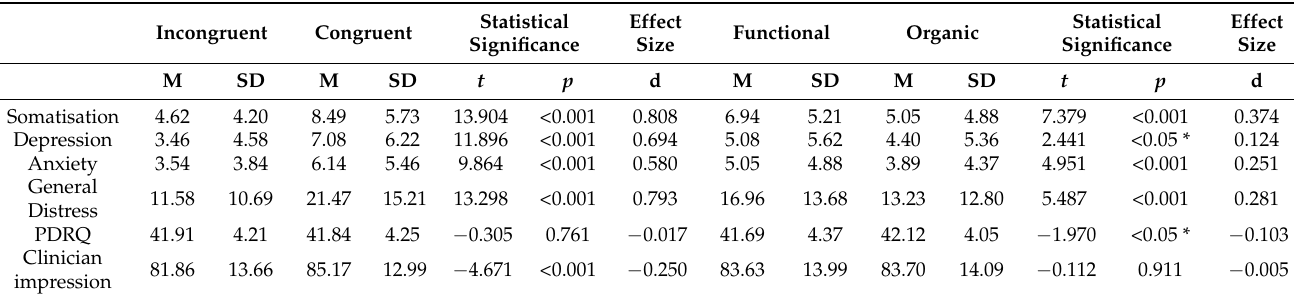
Table 3. Comparison of outcomes by congruence and diagnosis.